Question: Looking at the figure, what chart type is it?
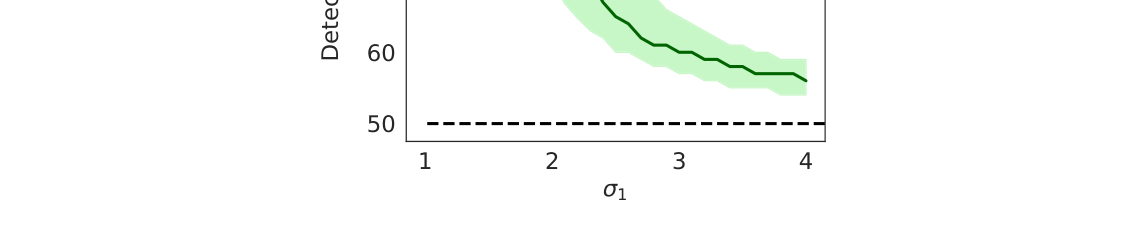
Answer: histogram